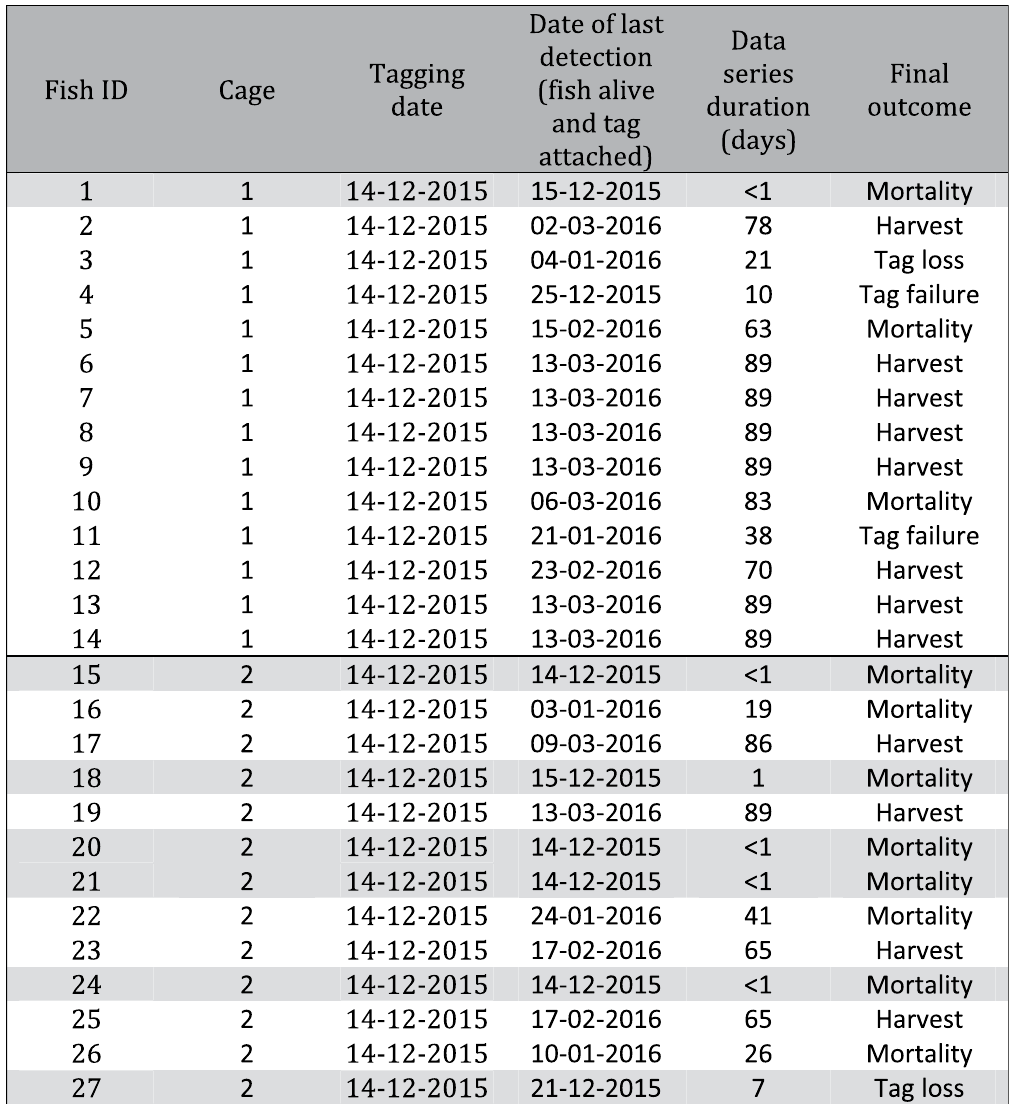
Table 1. Overview of individual detection series duration.Fish removed from analysis are highlighted in grey. Final outcomes other than harvest were established based on the animals’ depth record. Tags abruptly rising to the surface and remaining there were classed as lost tags, tags sinking to the bottom of the cage and remaining there were classed as mortalities, tags abruptly ending transmissions were classed as tag